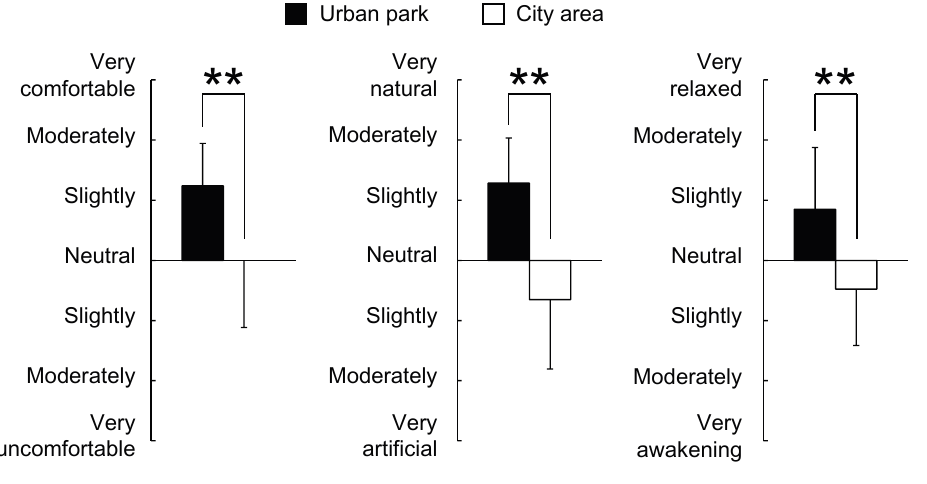
Figure 6. Comparison of subjective scoring for “comfortable”, “natural”, and “relaxed” feelings between the two environments according to the semantic differential method. N = 23, mean ± standard deviation. ** p < 0.01, determined by the Wilcoxon signed-rank test (one-sided).